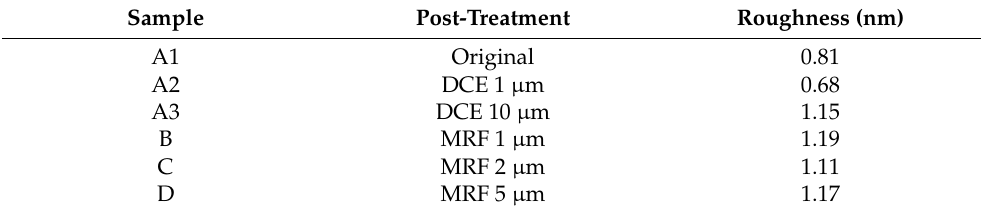
Table 1. Sample preparation methods and roughness on the sample